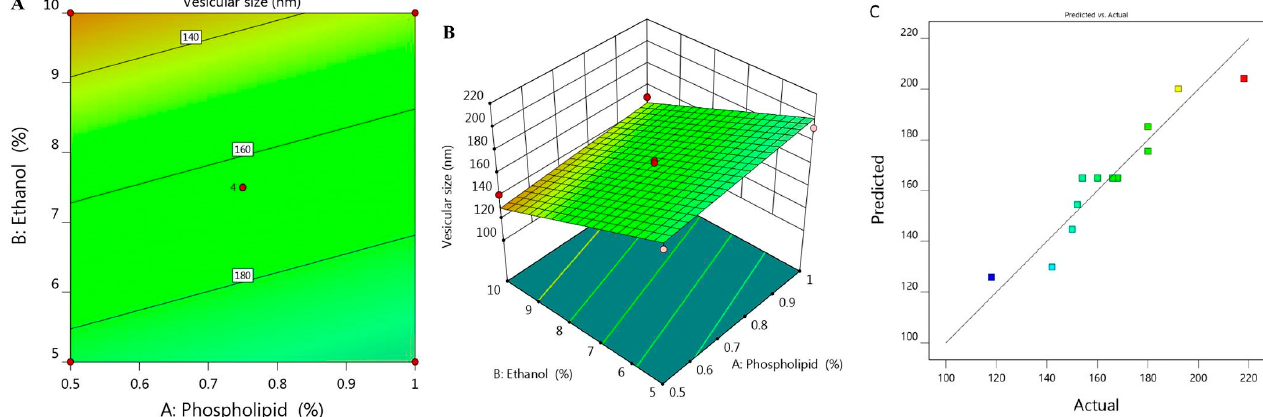
Figure 1. ( A ) 2D contour graph, ( B ) 3D response surface plot demonstrating the influence of independent variables (X 1 ) and (X 2 ) on ethosome vesicular size (Y 1 ) and ( C ) linear correlation plot between actual and predicted values for response (Y 1 ).